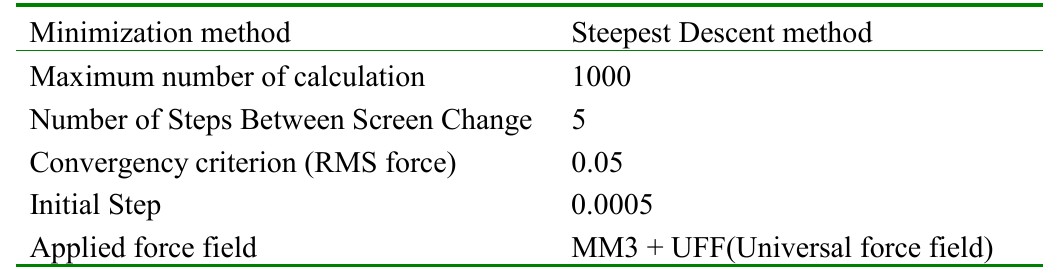
Table 2. The conditions of energy